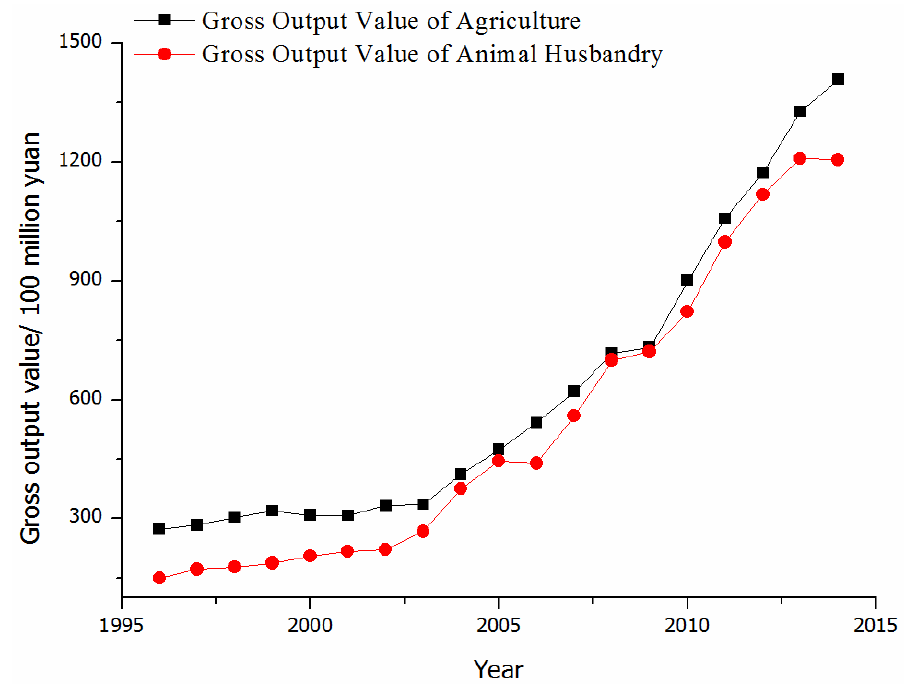
Figure 6. Gross output value of agriculture and animal husbandry in the IMP from 1996 to 2014.